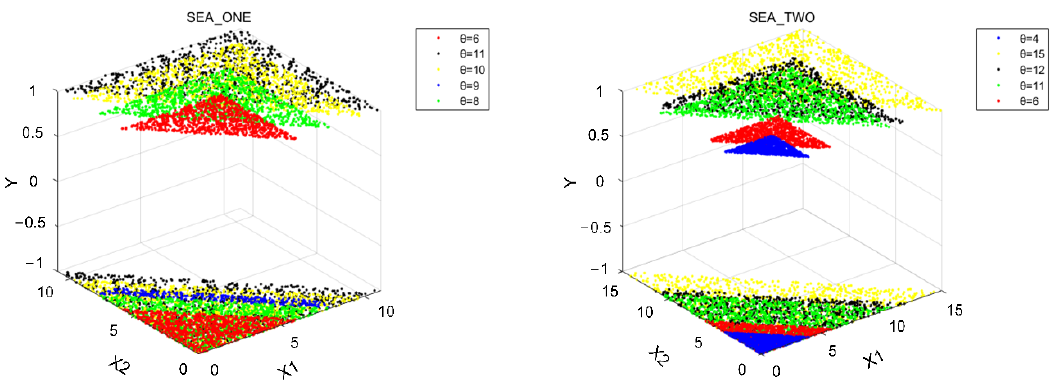
Figure 1. Concept distribution of SEA_ONE and SEA_TWO with different θ .